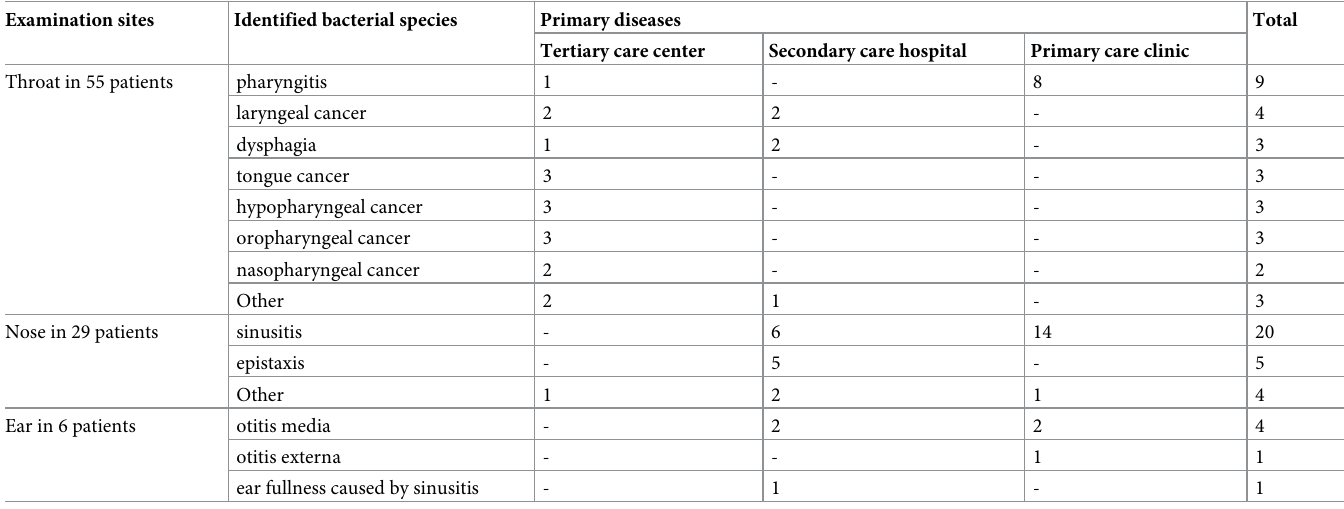
Table 1. Primary diseases requiring endoscopic